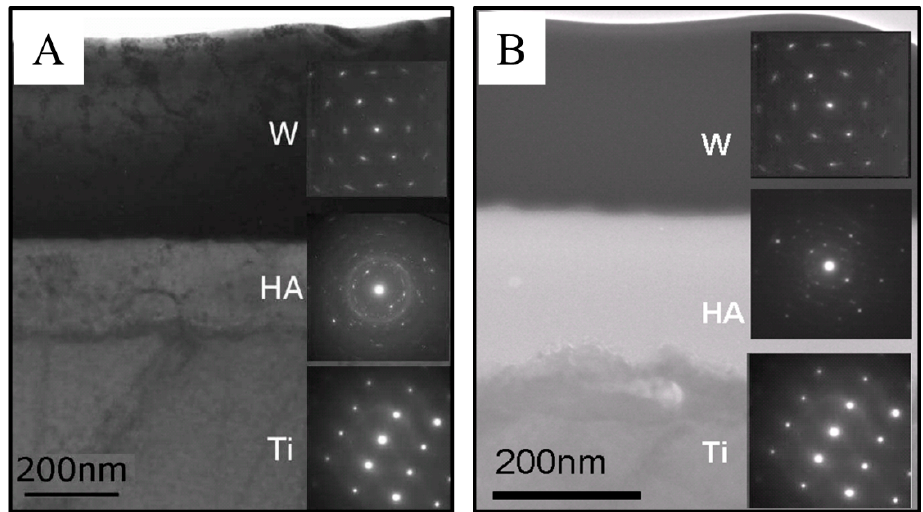
Figure 1. Bright field TEM image of ( A ) the tungsten / HA / Ti lamellar showing the HA thin film deposited on a CPTi substrate with associated selected area electron diffraction (SAED) patterns of the crystalline W protective coating, polycrystalline HA coating and crystalline Ti substrate and ( B ) the tungsten / SiHA3 / Ti lamellar showing an amorphous SiHA3 coating on a CPTi substrate and associated SAED.